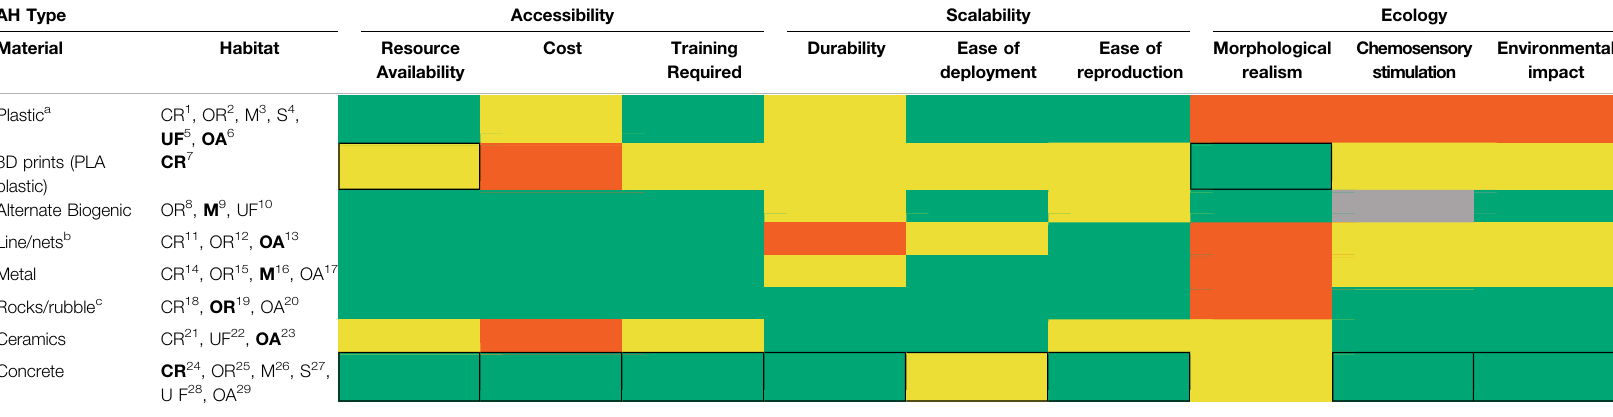
TABLE 2 | Performance of common Arti fi cial Habitat (AH) types used in aquatic research, given by their construction materials and the habitats they are designed to mimic, relative to three groups of metrics (accessibility, scalability,andecology).Green=highperformance,yellow=moderateorange=poor,and;grey=unknown.Detaileddescriptionsofeachmetricandperformancecriteriaareprovidedin Table1